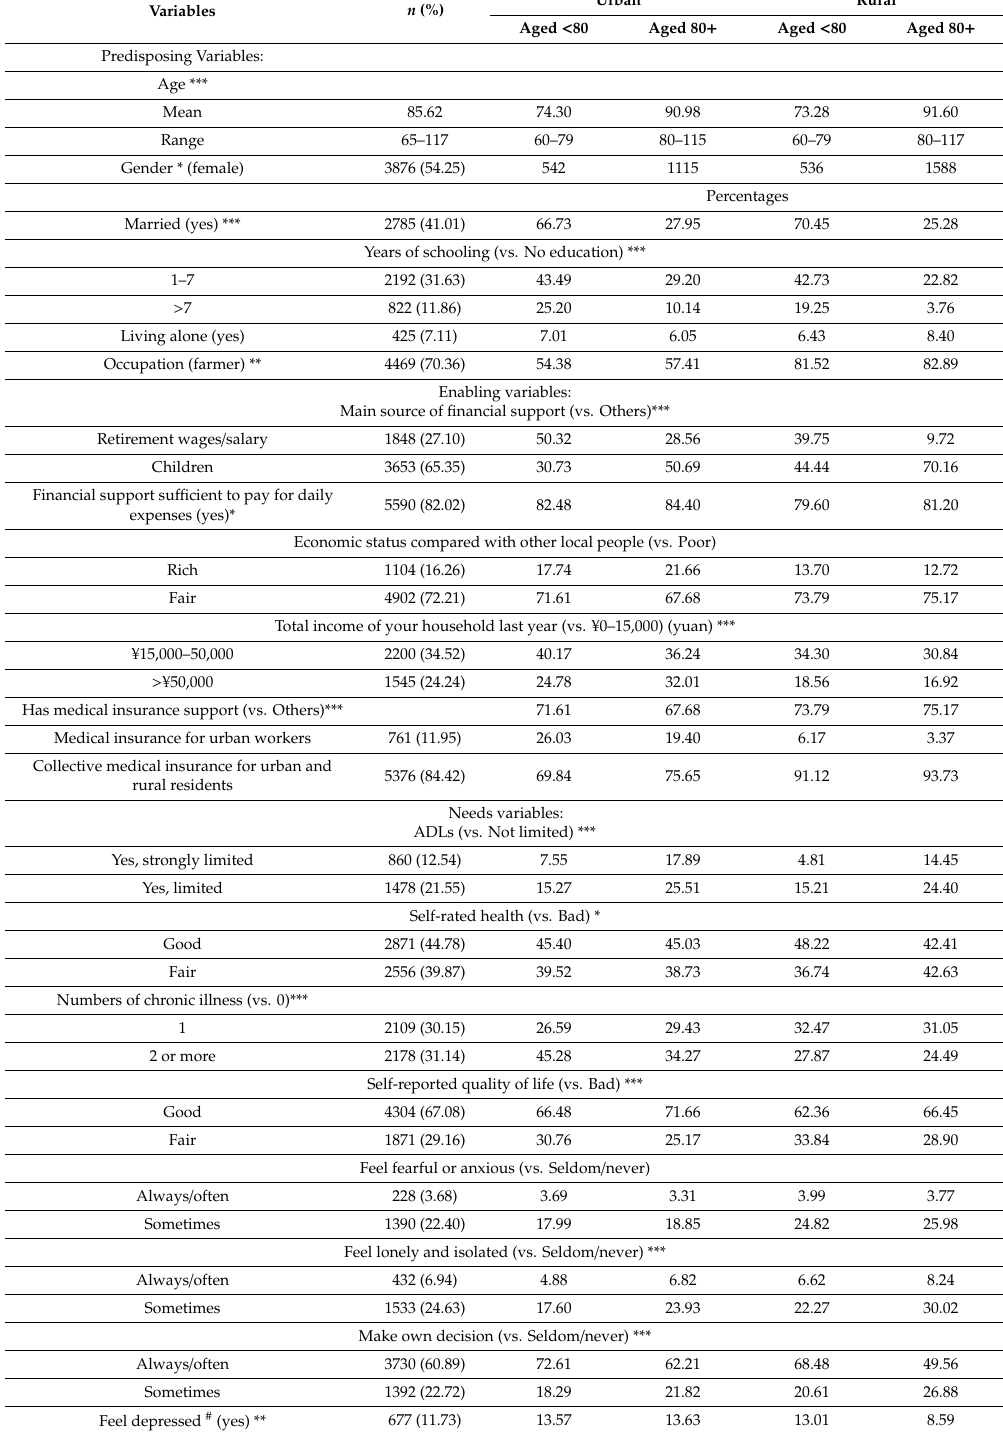
Table 1. Predisposing, enabling and need characteristics by age cohort and